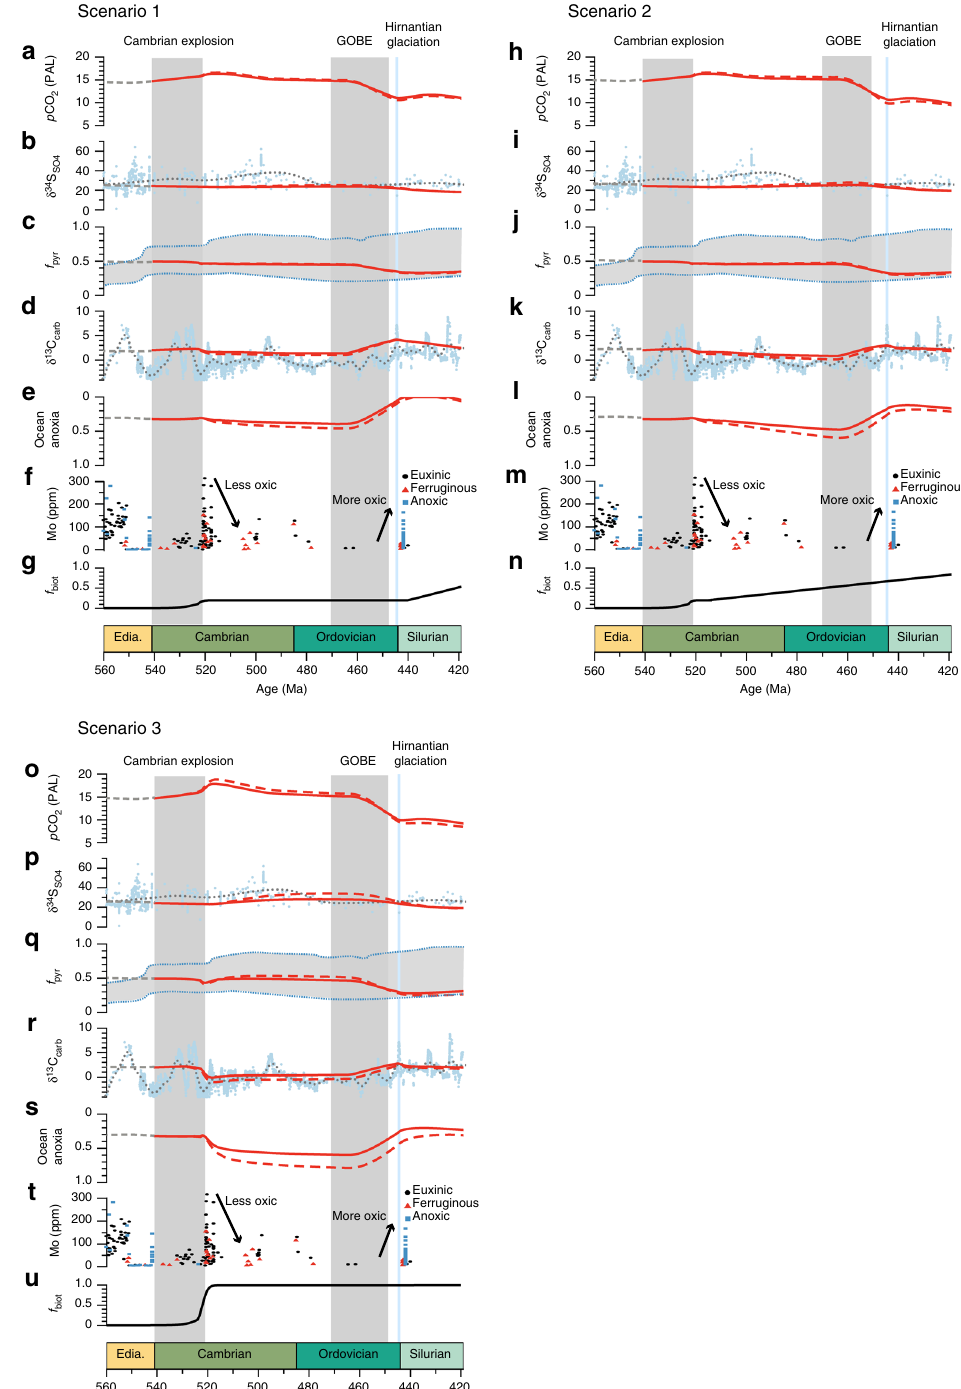
Fig. 5 COPSE model with the addition of the evolution of bioturbation. Scenario 1 shows the effect of the sedimentary response that scales linearly with bioturbation intensity. Scenarios 2 and 3 assume that the effects of bioturbation on sediment geochemistry occur non-linearly (strong response for low levels of bioturbation), where Scenario 2 follows a gradual increase of the areal extent of bioturbation and Scenario 3 shows the maximum effect at the Ediacaran-Cambrian boundary (see panels g , n , u ). a , h , o Atmospheric CO 2 . b , i , p Average sulphate δ 34 S of seawater. c , j , q Pyrite fraction of sulphur burial. d , k , r Average δ 13 C of carbonate. e , l , s Degree of ocean anoxia. Model outcomes (in red) are fi tted to the δ 13 C carb and δ 13 S SO4 proxies (grey dotted line represents a LOESS fi t), predictions for the relative importance of pyrite for the total sulphur burial rate (blue dotted lines represent the range of model results presented in ref. 44 ) and compared to a summary of the evolution of sedimentary Mo concentrations over time ( f , m , t ). Solid lines represent the model outcomes with anoxia feedback, dashed lines represent the model outcomes without anoxia feedback. Grey shaded areas indicate the Cambrian explosion (540 – 521 Ma) and the Great Ordovician Biodiversi fi cation Event (GOBE; 470 – 450 Ma). Blue shaded line indicates the Hirnantian glaciation